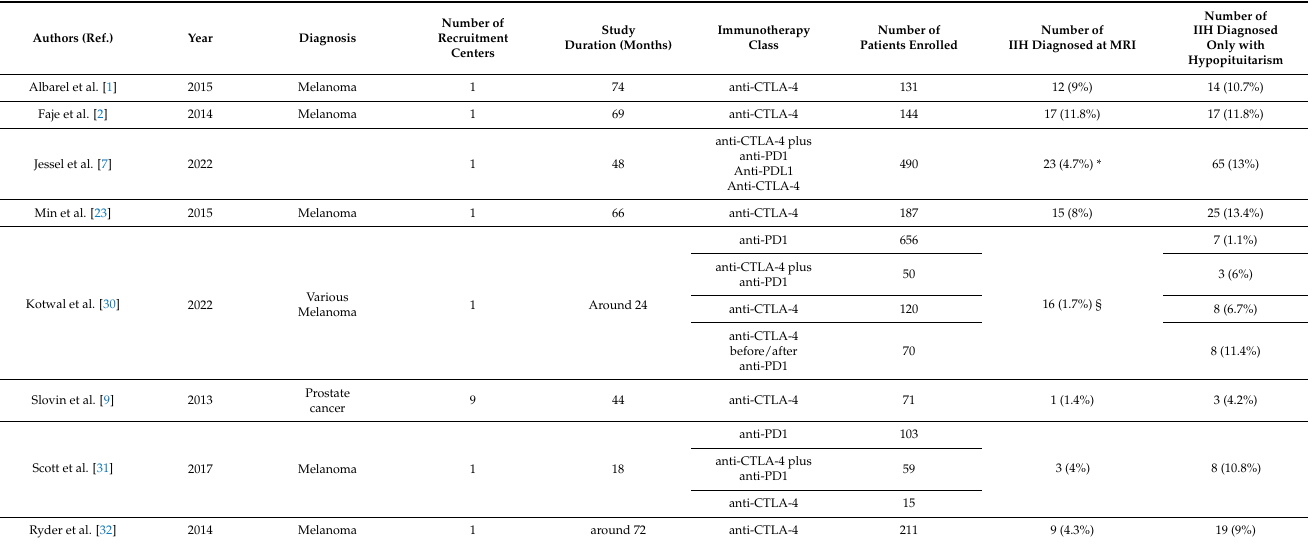
Table 4. Representative studies described cases of hypophysitis during ICI, classified according to different diagnostic criteria. * Brain imaging available for 49 pts; §: brain imaging available for 25